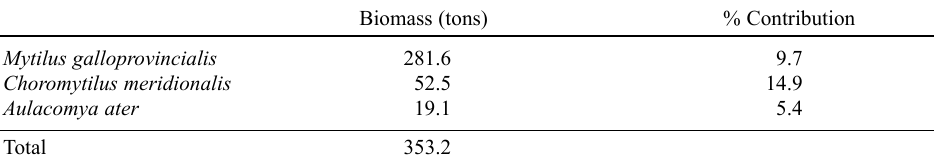
Total rocky intertidal wet biomass (tons) of Mytilus galloprovincialis, Choromytilus meridionalis and Aula- comya ater within Saldanha Bay and Langebaan Lagoon. The percentage contribution made by each species to the total mussel biomass of the system is given Biomass (tons) % Contribution Mytilus galloprovincialis